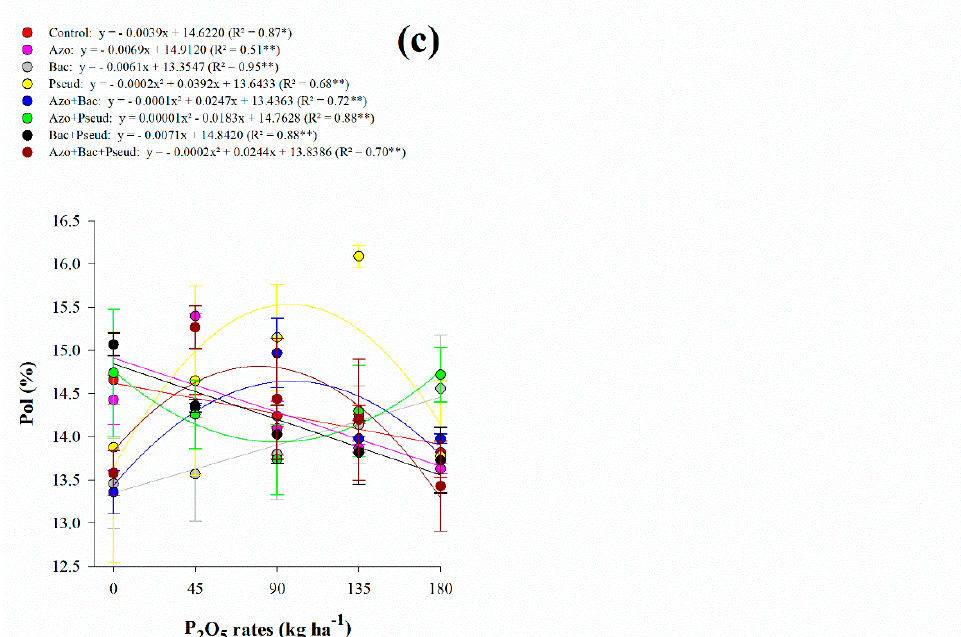
Figure 2. Interaction between P 2 O 5 rates and inoculations for fiber ( a ), soluble solids content (Brix) ( b ) and apparent sucrose of juice (Pol) ( c ) content of sugarcane. Error bars indicate the standard deviation of the mean ( n = 3). **, * and ns: significant at 1% at p < 0.01, 5% at p < 0.05 and p > 0.01 and not significant, respectively.